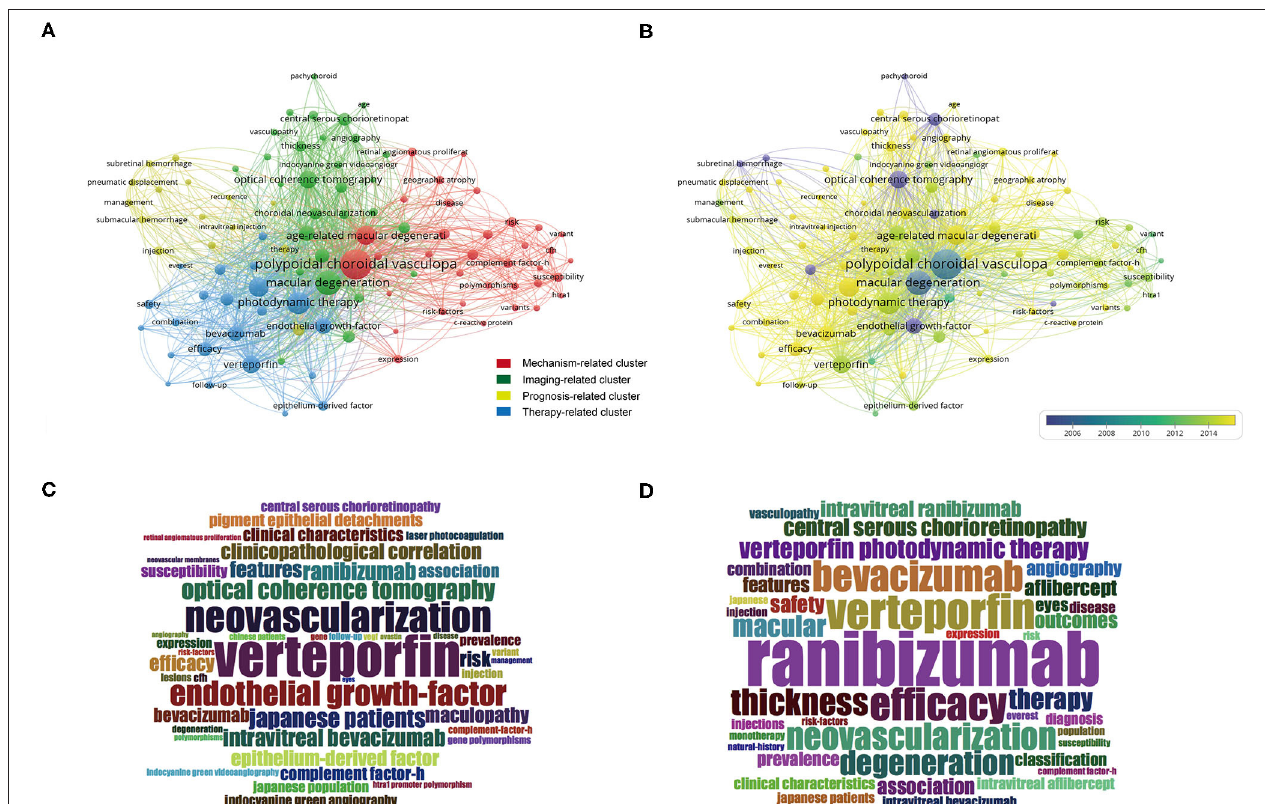
FIGURE 4 | Keywords analysis by VOSviewer. (A) Keywords were divided into 4 clusters by co-occurrence frequency, including mechanism-related cluster (red), imaging-related cluster (green), prognosis-related cluster (yellow), and therapy-related cluster (blue). (B) All the keywords were color-coded by the average time